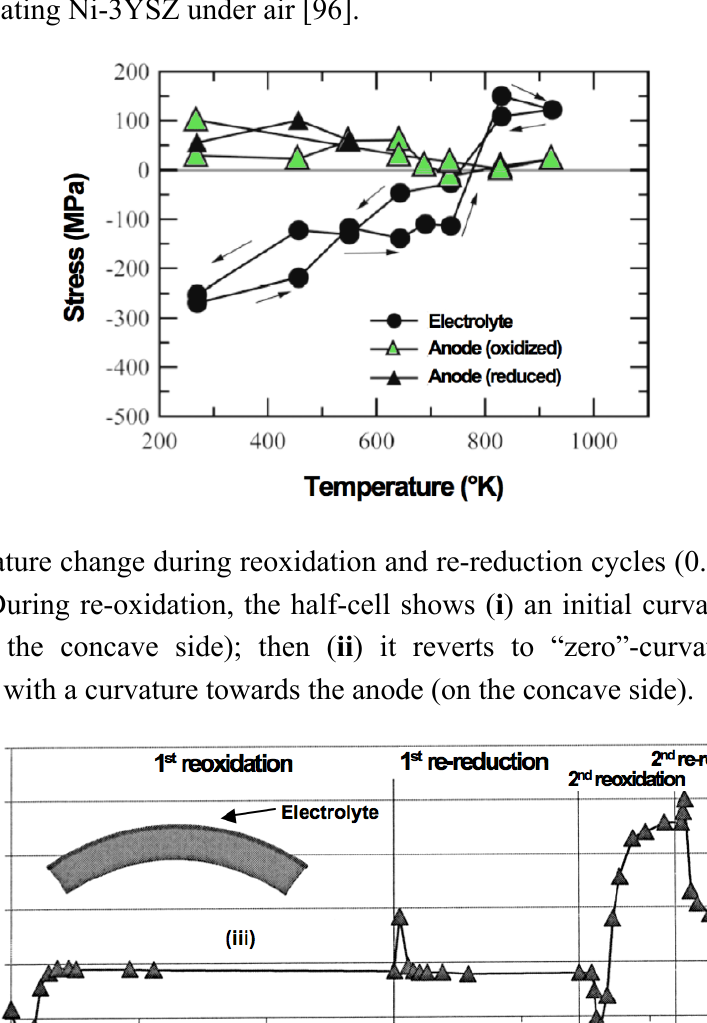
Figure 6. Changes in stresses in 10ScSZ (scandium-stabilized zirconia) electrolyte and anode during heating Ni-3YSZ under air [96].